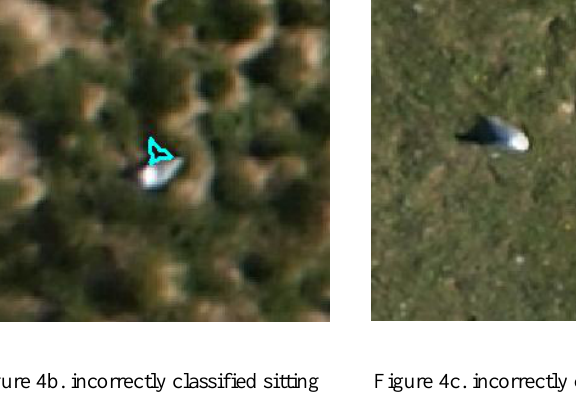
Figure 4a. correctly classified standing bird with shadow